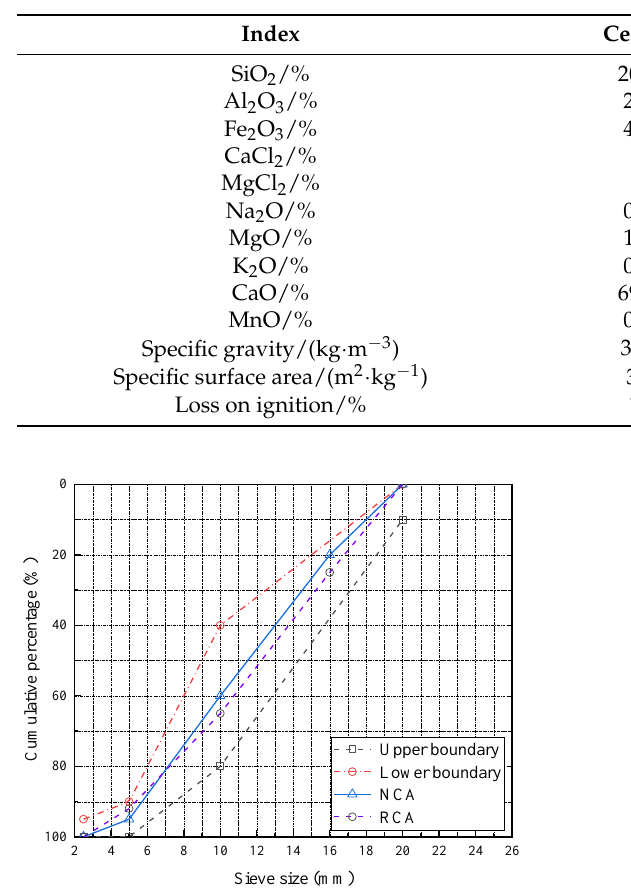
Table 1. Main chemical composition and physical properties of cement and SF.